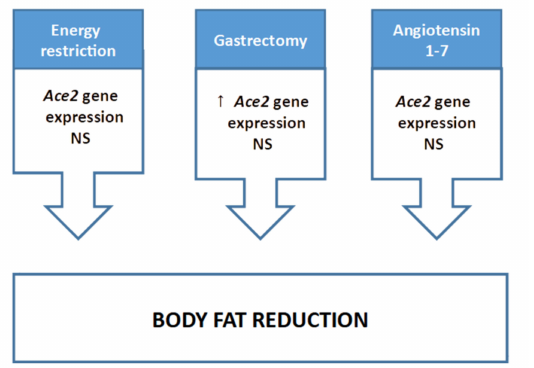
Figure 3. Effects of energy restriction and other non-dietary treatments devoted to reducing body fat on Ace2 gene expression in adipose tissue. NS: non-significant; ↑